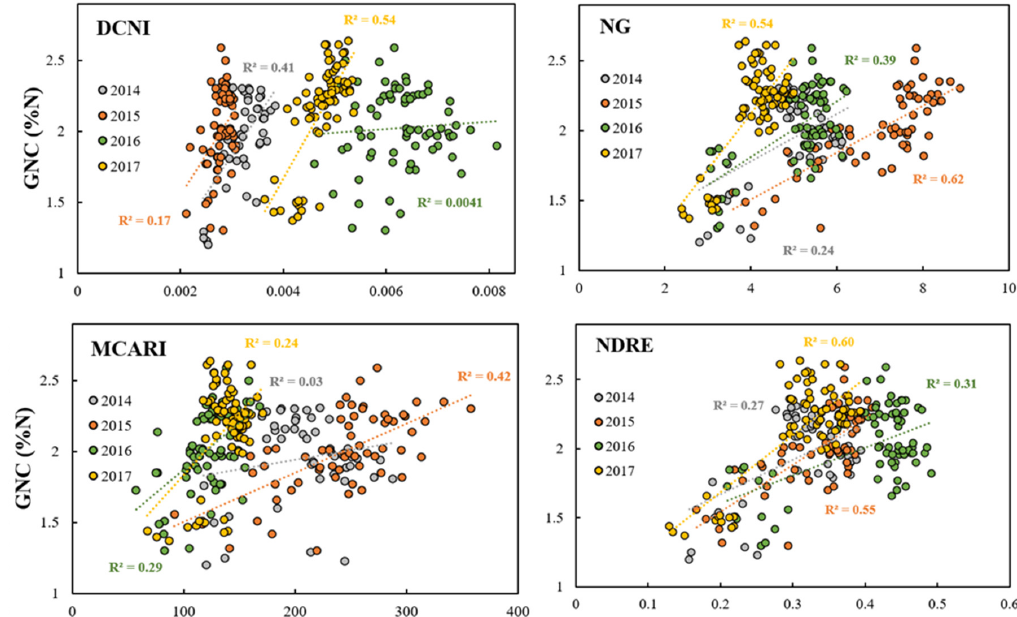
Figure 10. Grain N concentration (GNC, %N) versus the readings of selected indices for the treatments with two post-plant irrigations over the experimental years. Dotted lines are the adjusted linear model and R 2 its coefficient of determination.